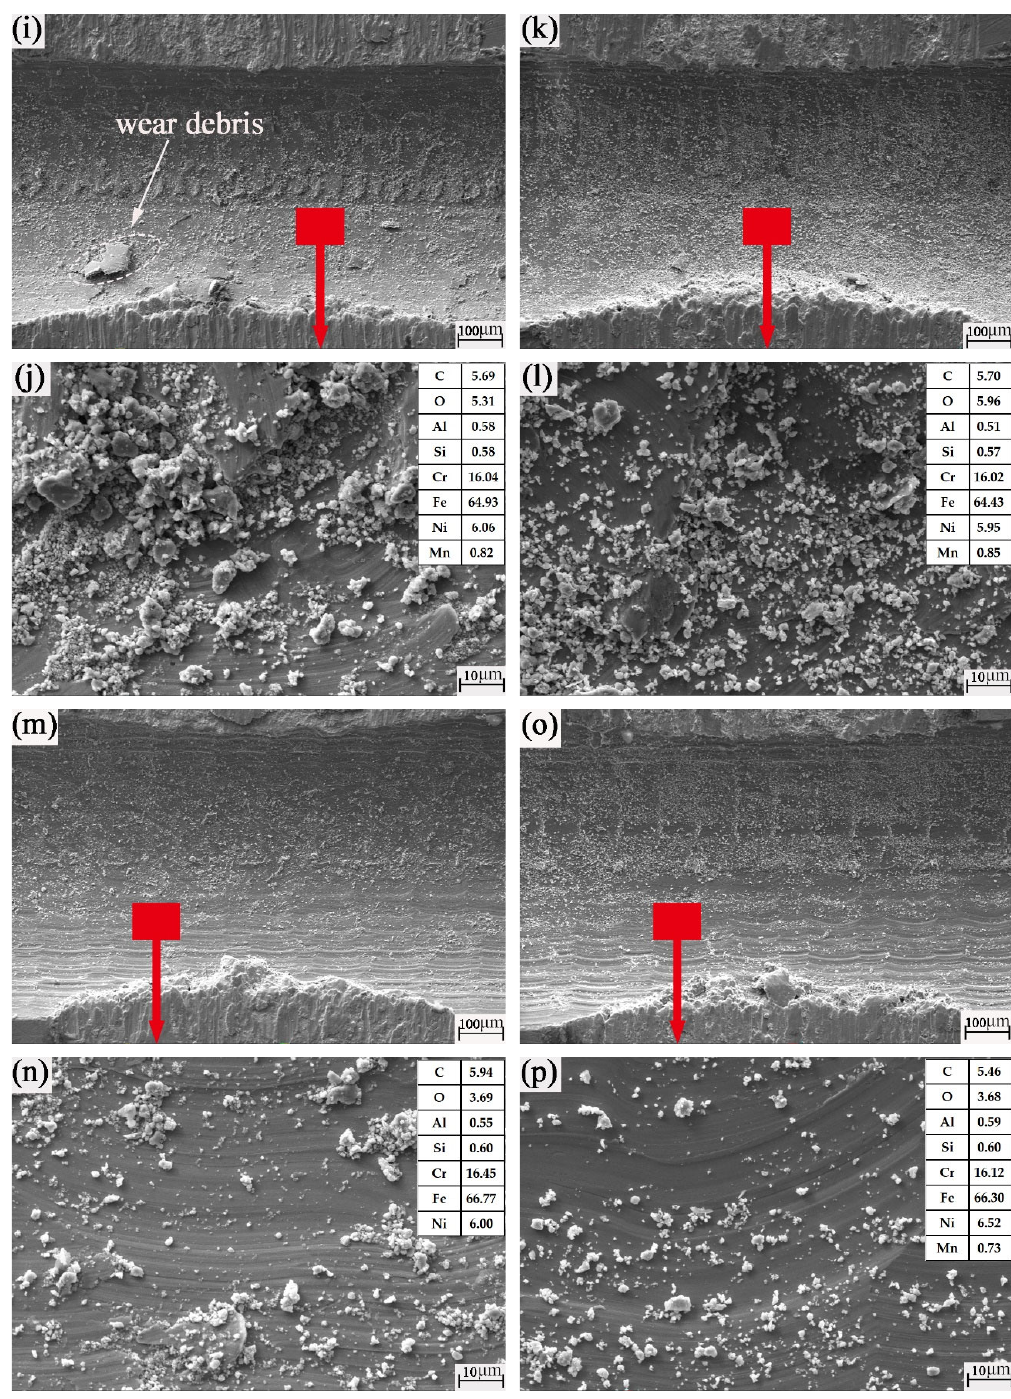
Figure 11. SEM images of the groove textured worn plates: ( a,b ) 0.4 mm groove width mechanical texture rotation radius of 15 mm; ( c,d ) 0.4 mm groove width mechanical texture rotation radius of 22.5 mm; ( e,f ) 0.6 mm groove width mechanical texture rotation radius of 15 mm; ( g,h ) 0.6 mm groove width mechanical texture rotation radius of 22.5 mm; ( i,j ) 0.8 mm groove width mechanical texture rotation radius of 15 mm; ( k,l ) 0.8 mm groove width mechanical texture rotation radius of 22.5 mm; ( m,n ) 1.0 mm groove width mechanical texture rotation radius of 15 mm; ( o,p ) 1.0 mm groove width mechanical texture rotation radius of 22.5 mm.